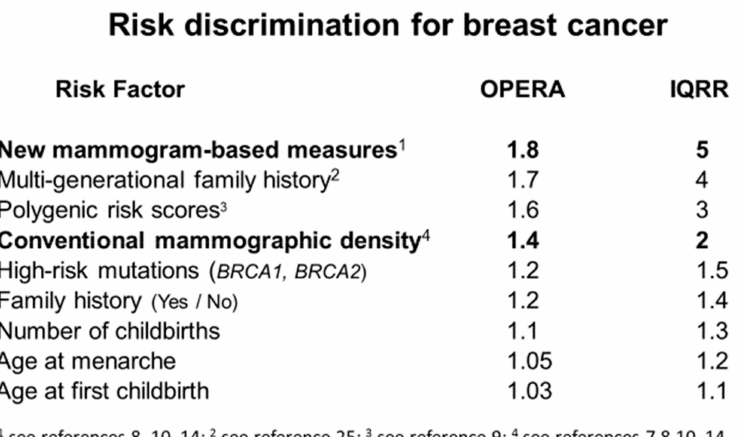
Figure 2. Risk discrimination for breast cancer based on the odds ratio per adjusted standard deviation (OPERA) (see [7]) and equivalent inter-quartile risk ratio